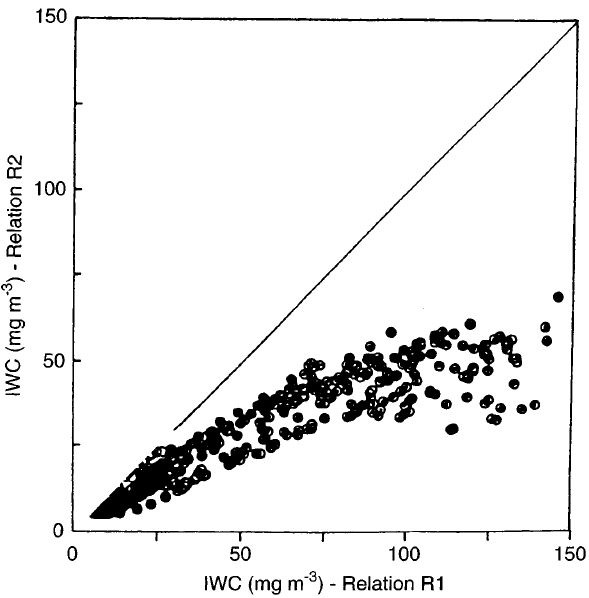
Fig. 9. Comparison of the IWC obtained by using two size-mass relationships ( R1 : bullett-rosette; R2 : irregular) applied to the same data set (cirrus measurements performed near ) 30 (cid:176) C during the mission 210 of the International Cirrus Experiment ICE/EUCREX)